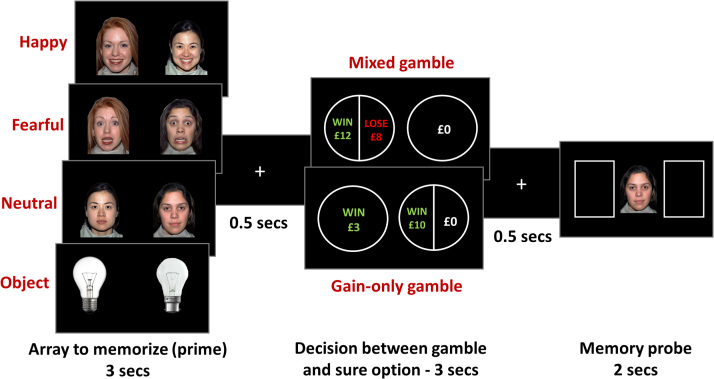
Trial design. On each trial, participants were first presented with a pair of faces (all happy, all fearful, or all neutral) or objects (light bulbs) and had 3 seconds to memorize it. They then had to decide whether to choose a sure option or a risky gamble. In mixed gamble trials, the sure option was always £0 and the mixed gamble involved a 50% chance to win the amount in green and a 50% chance to lose the amount in red. In gain-only gamble trials, the sure option was a small guaranteed gain, and the gamble involved a 50% chance to win a higher amount and a 50% chance to get £0. Finally, a probe from the first array was presented and participants had to report its position.